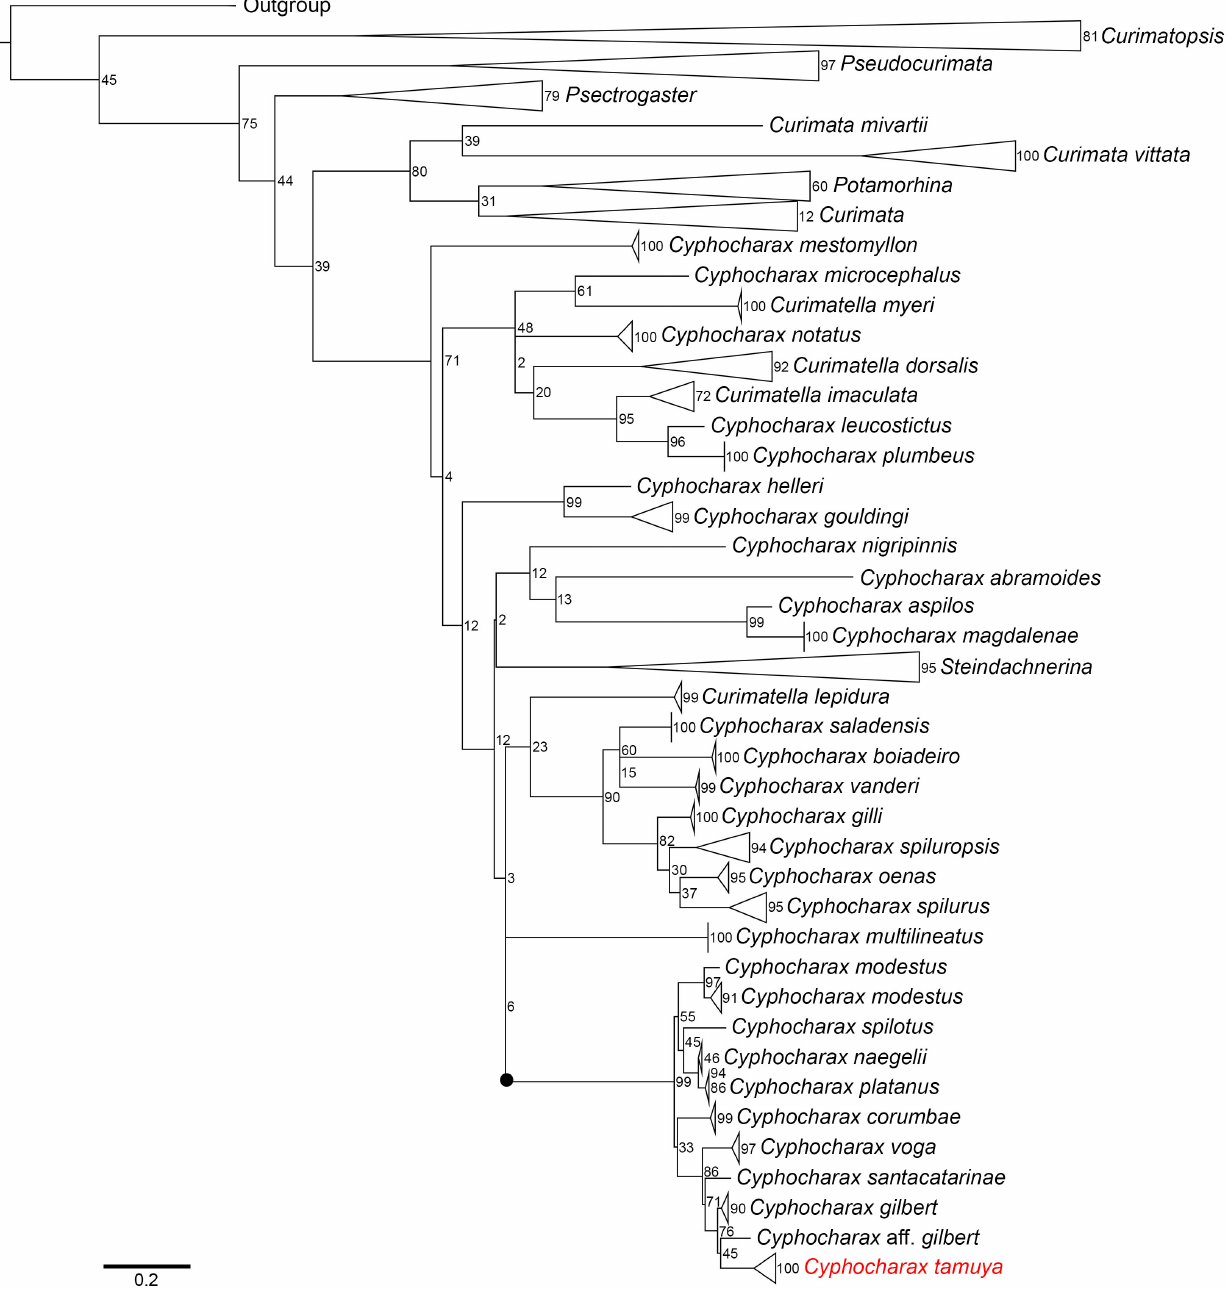
FIGURE 4 | Maximum likelihood tree of Curimatidae using COI (210 sequences with 657 bp) depicting the Cyphocharax gilbert clade (black dot). Numbers at right of nodes represent bootstrap